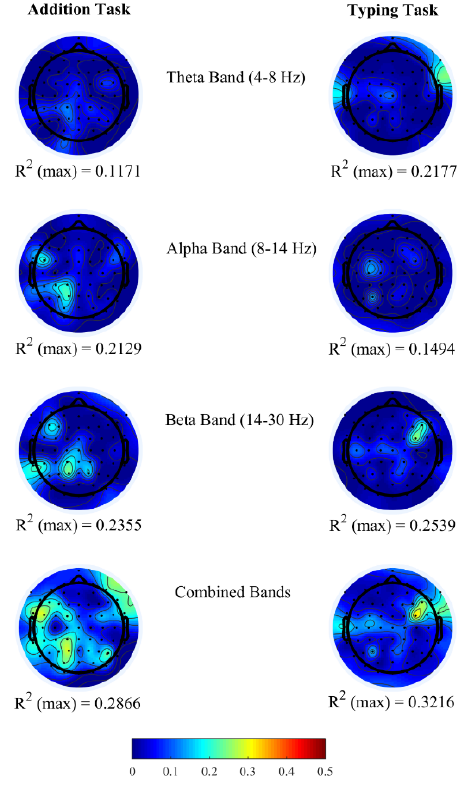
Table 4. Correlation coefficients ( ρ ) between brain band pairs corresponding to the EEG electrodes with highest R 2 single regressor linear models.